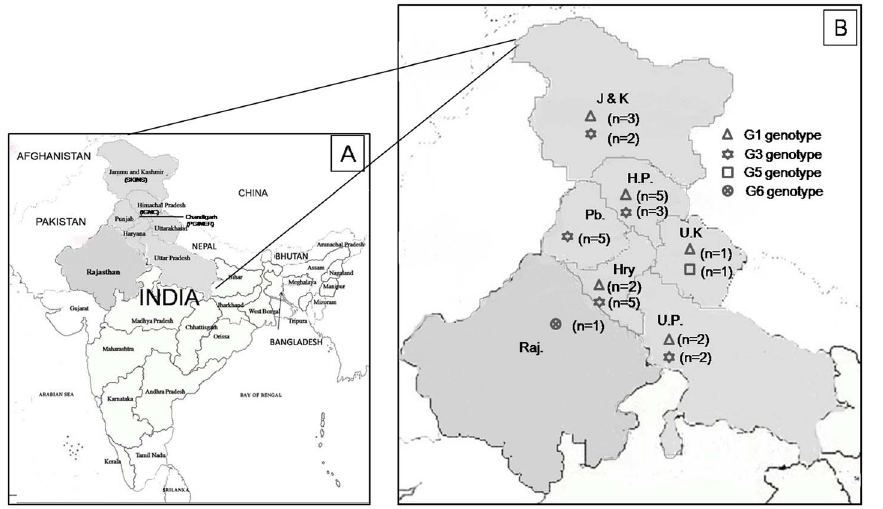
Figure 1. Geographical distribution of the cystic echinococcosis patients. A) Map of India showing the location of three hospitals and geographical origin of cystic echinococcosis patients (in grey) analyzed in this study. B) State wise geographical distribution of 4 different genotypes of Echinococcus granulosus in North India. The number of collected samples for each state is indicated. J& K indicates the Jammu and Kashmir, H.P - Himachal Pradesh, Pb - Punjab, Hry - Haryana, U.K - Uttarakhand, U.P - Uttar Pradesh, Raj-Rajasthan, PGIMER-Post Graduate Institute of